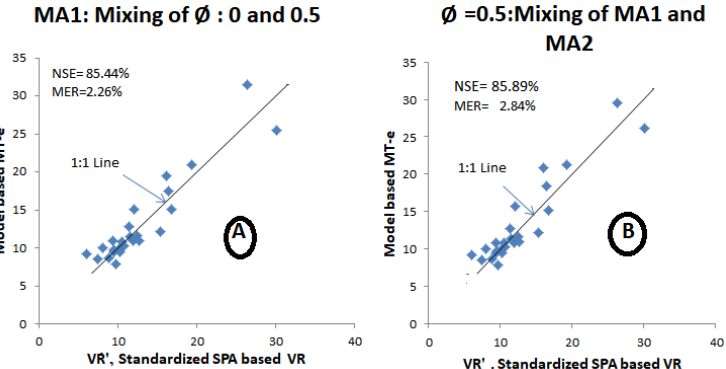
Figure 3. Comparison of M T-e with SPA-based standardized reservoir volume with cutoff = SHIm: ( A ) and ( B ) respectively, represent Combination-A and Combination-B.